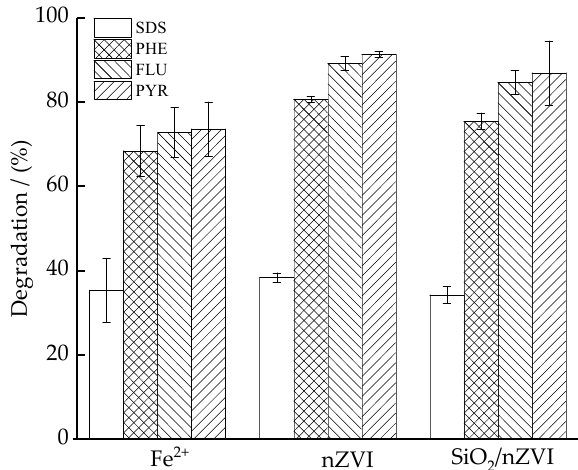
Figure 4. The degradation of PAHs and SDS in soil washing effluents with PS activated by different sources of iron (Fe 2+ , nZVI, and SiO 2 /nZVI). Values are presented as means and standard deviation.